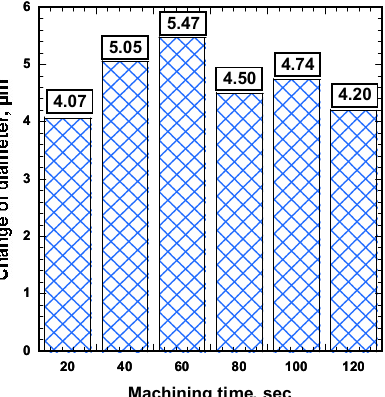
Figure 7. Machining diameter against the machining time at 80,000 rpm (10 Hz, 550 mT, and 0.5 µm).